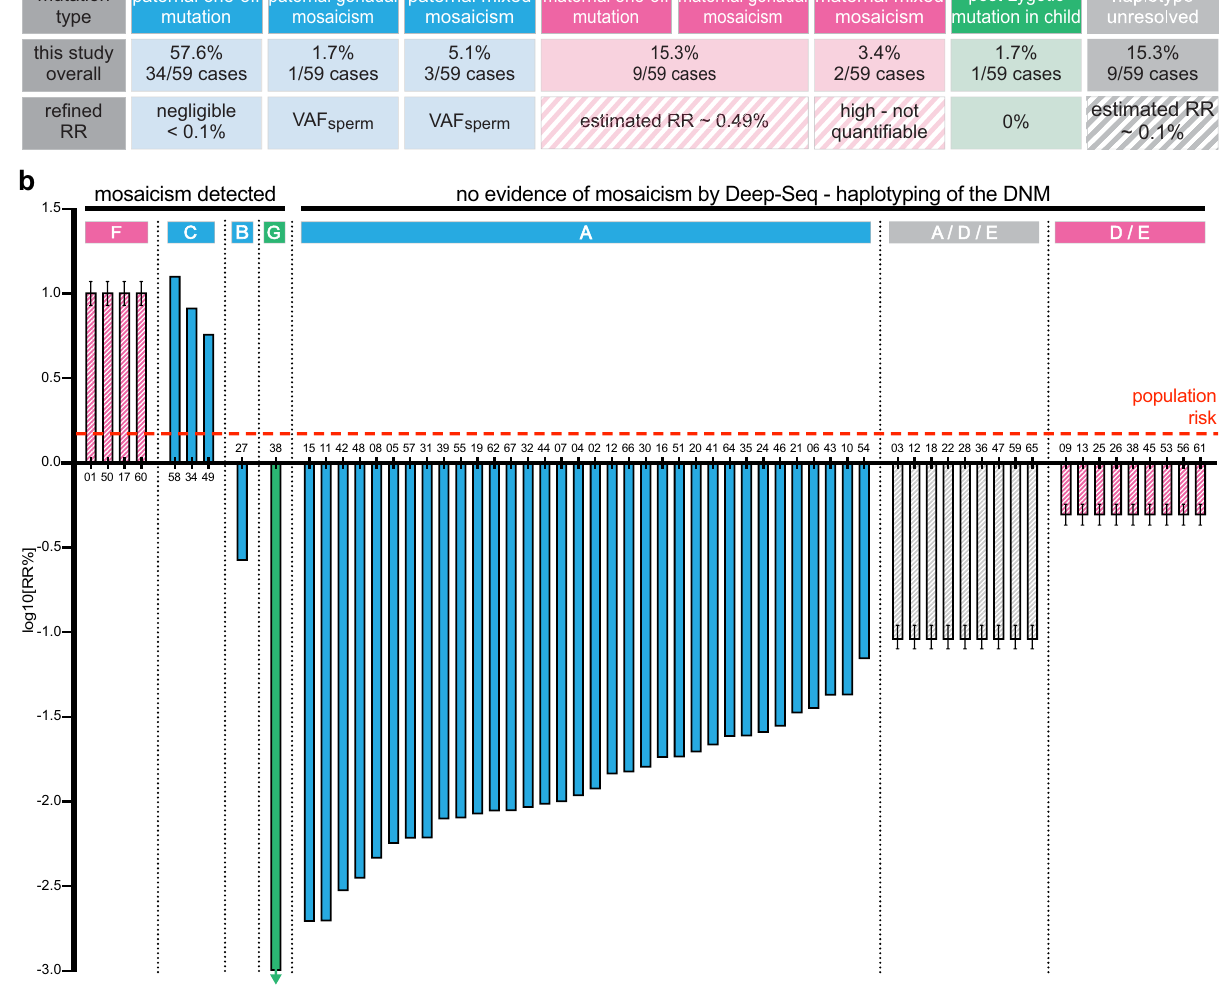
Fig. 4 | Overview of the results of the PREGCARE study showing re fi nement of individual recurrence risk for all families. a Summary table of the PREGCARE results for the 59 DNMs analyzed in this study and overview of the re fi ned recur- rence risk (RR). b Personalized recurrence risk (RR%) estimates for each of the 60 families (61 DNMs) enrolled in the PREGCARE study represented on a logarithmic scale. The red dotted line represents the generic population RR given to couples who have had a child with a DNM (~1.5%). Individual family numbers are indicated onthe x -axis.Eachbarrepresentsthenewre fi nedRRforagivenfamilyenrolledinto the PREGCARE study. For ease of visualization, bars are coloured according to the origin of the DNM [blue (paternal), pink (maternal), green (post-zygotic/proband) or grey (the parental origin could not be resolved)]. The RR can be quanti fi ed for